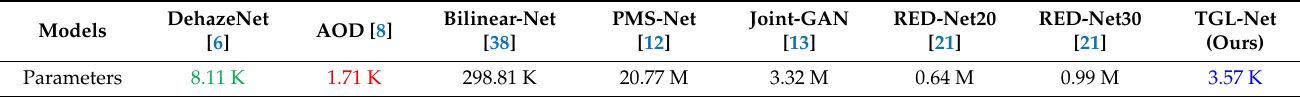
Table 6. Numbers of parameters in different network models.